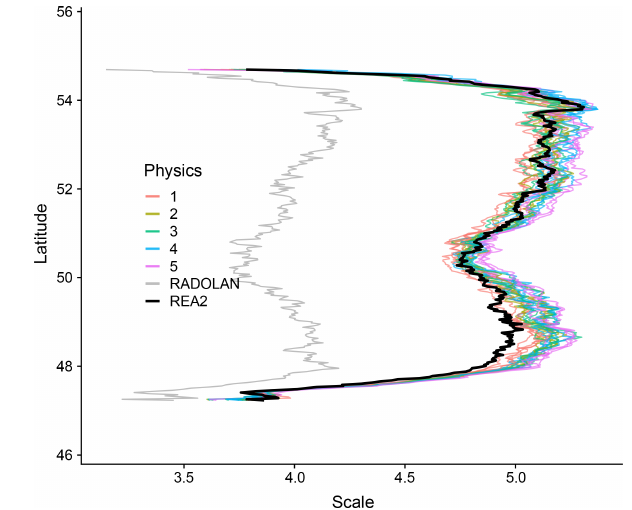
Figure 6. Map of central scales, averaged over all instants with non-zero precipitation and all longitudes. Ensemble members with the same physics setting have the same colour, and RADOLAN and REA2 are black and grey, respectively. Only pixels with available RADOLAN observations and at least 21d of non-zero rain were